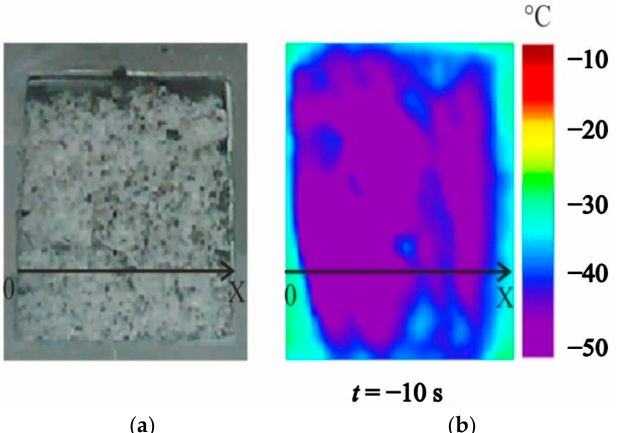
Figure 8. ( a ) Photo of a reservoir with a sample; and ( b ) thermal imaging photograph of the powder surface (photos were taken 10 s before the start of combustion).